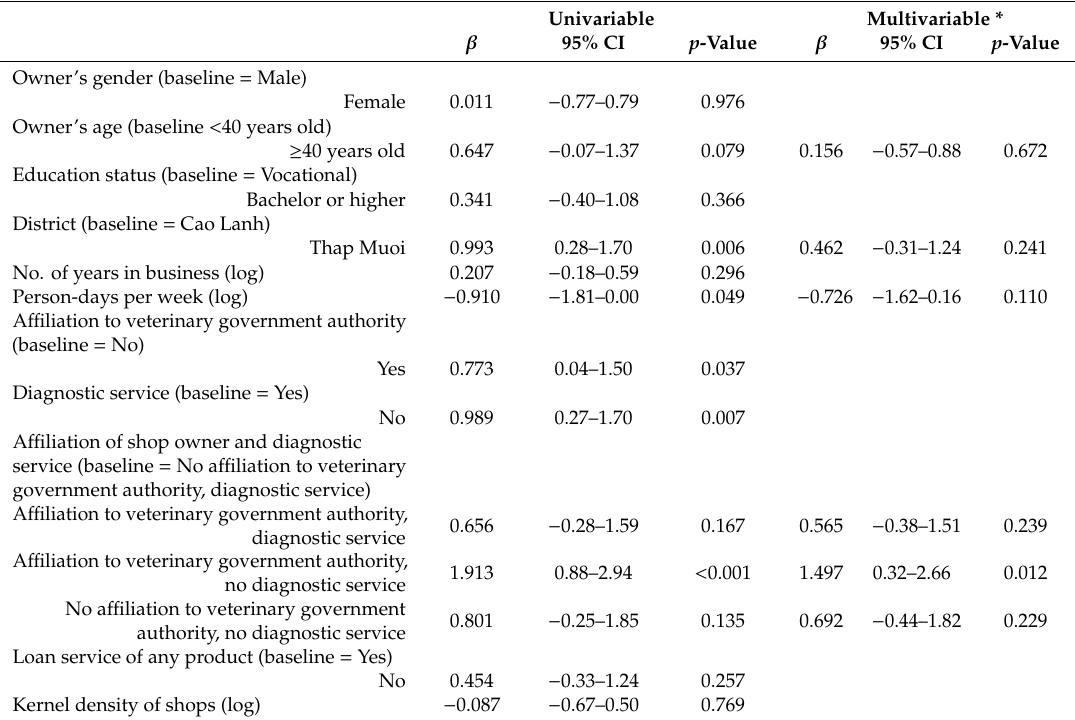
Table 3. Linear models that investigate factors associated with a higher share of income consisting of antimicrobial